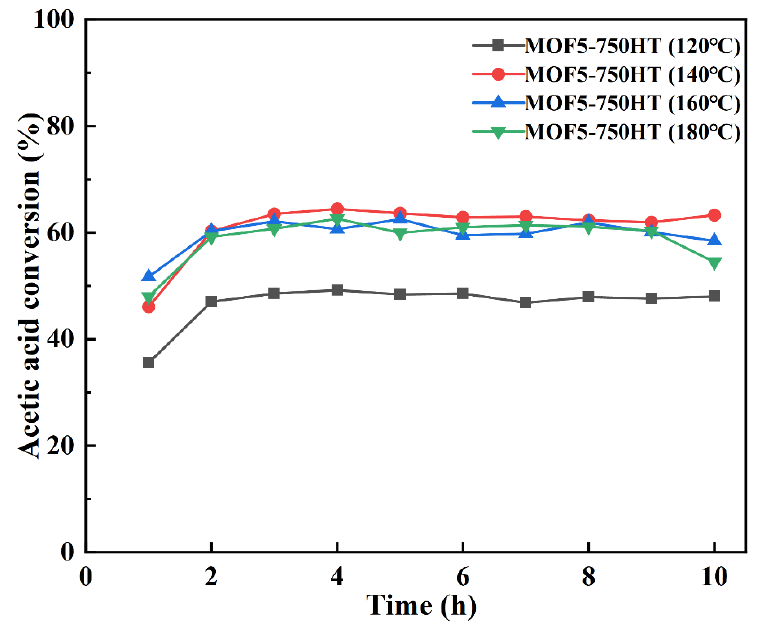
Figure 5. The change of acetic acid conversion of MOFs precursors prepared at different hydrothermal temperatures and calcined at 750 ◦ C with time . Table 1. Specific surface area, pore volume and pore size data of each sample.